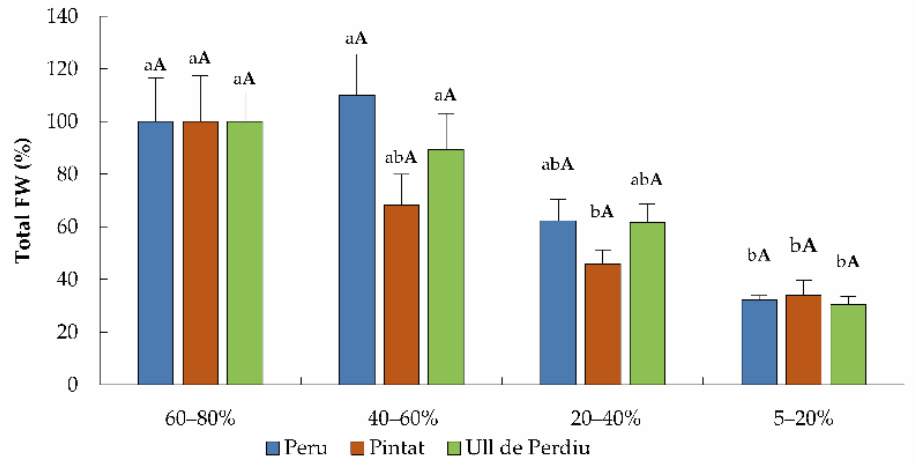
Figure 3. Effect of water stress on total fresh weight for the three Phaseolus lunatus cultivars expressed as percentage reduction with respect to their respective control (60–80% soil moisture). Absolute values of total FW: Peru: 63.84 gr, Pintat: 84.44 gr and Ull de Perdiu: 73.05 gr. Lowercase letters indicate significant differences within each cultivar and uppercase letters (in bold) between cultivars, but within treatments, according to Tukey’s test (α = 0.05). p values according to one-way ANOVA.